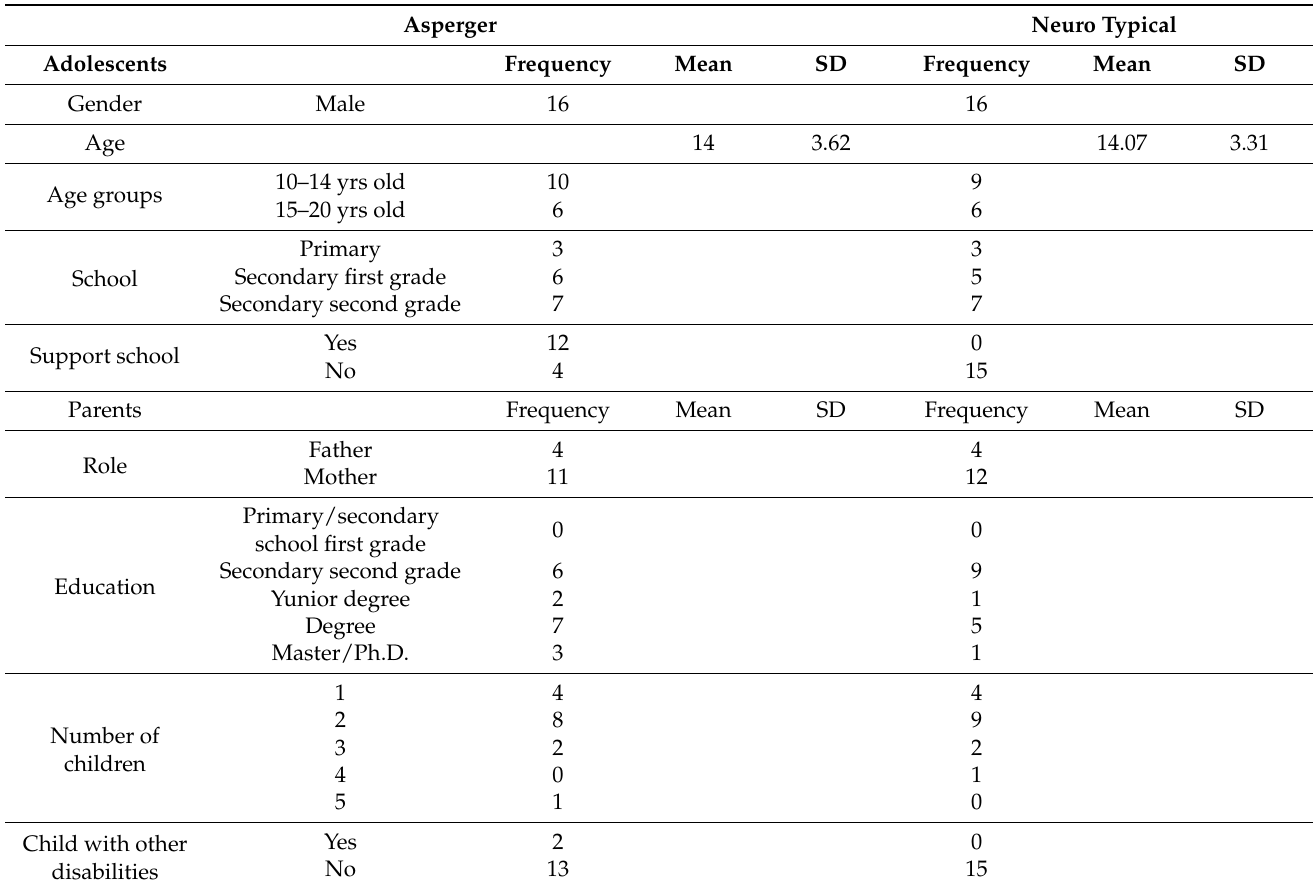
Table 1. Sociodemographic characteristics of the